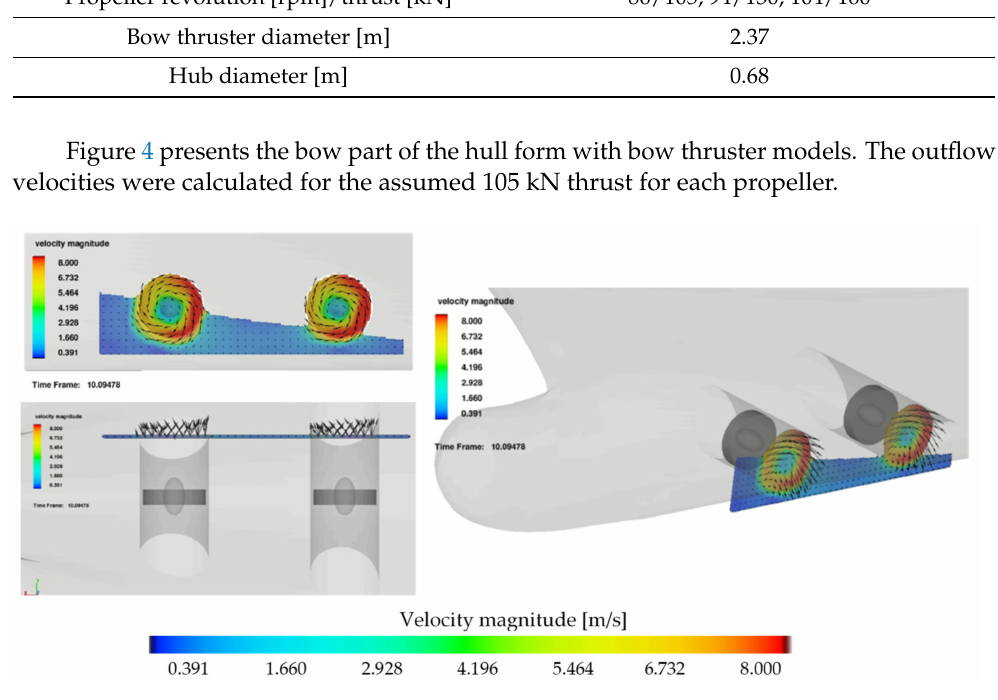
Figure 4. Numerical models of the bow thrusters.